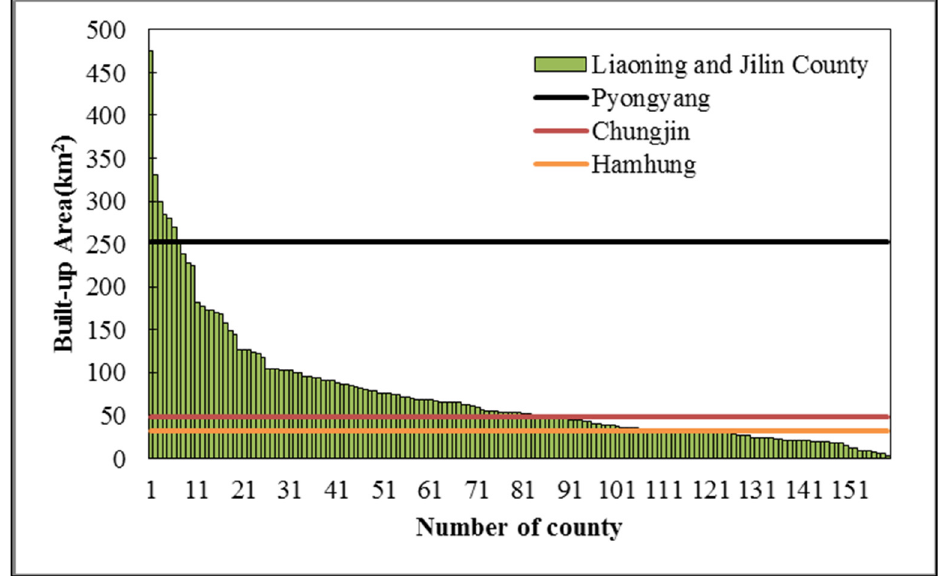
Table 4. Comparison of typical cities in DPRK, China, and ROK [km 2 ].